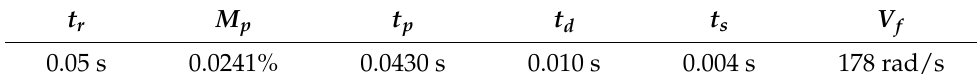
Figure 6. Systems used for test the ANN set with real systems. Table 7. Variables of the dynamic response in real